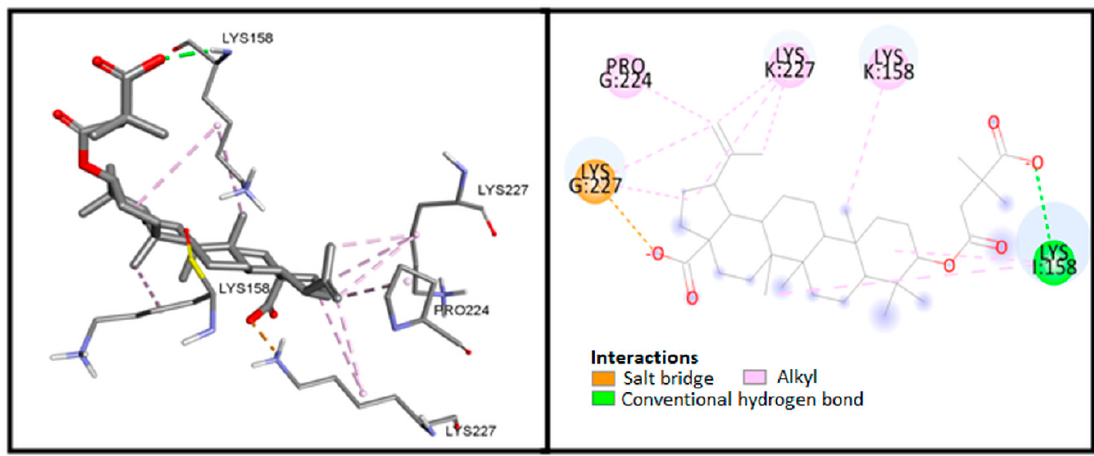
Figure 2. Visualization of interaction between BVM and CA-CTD-SP1.